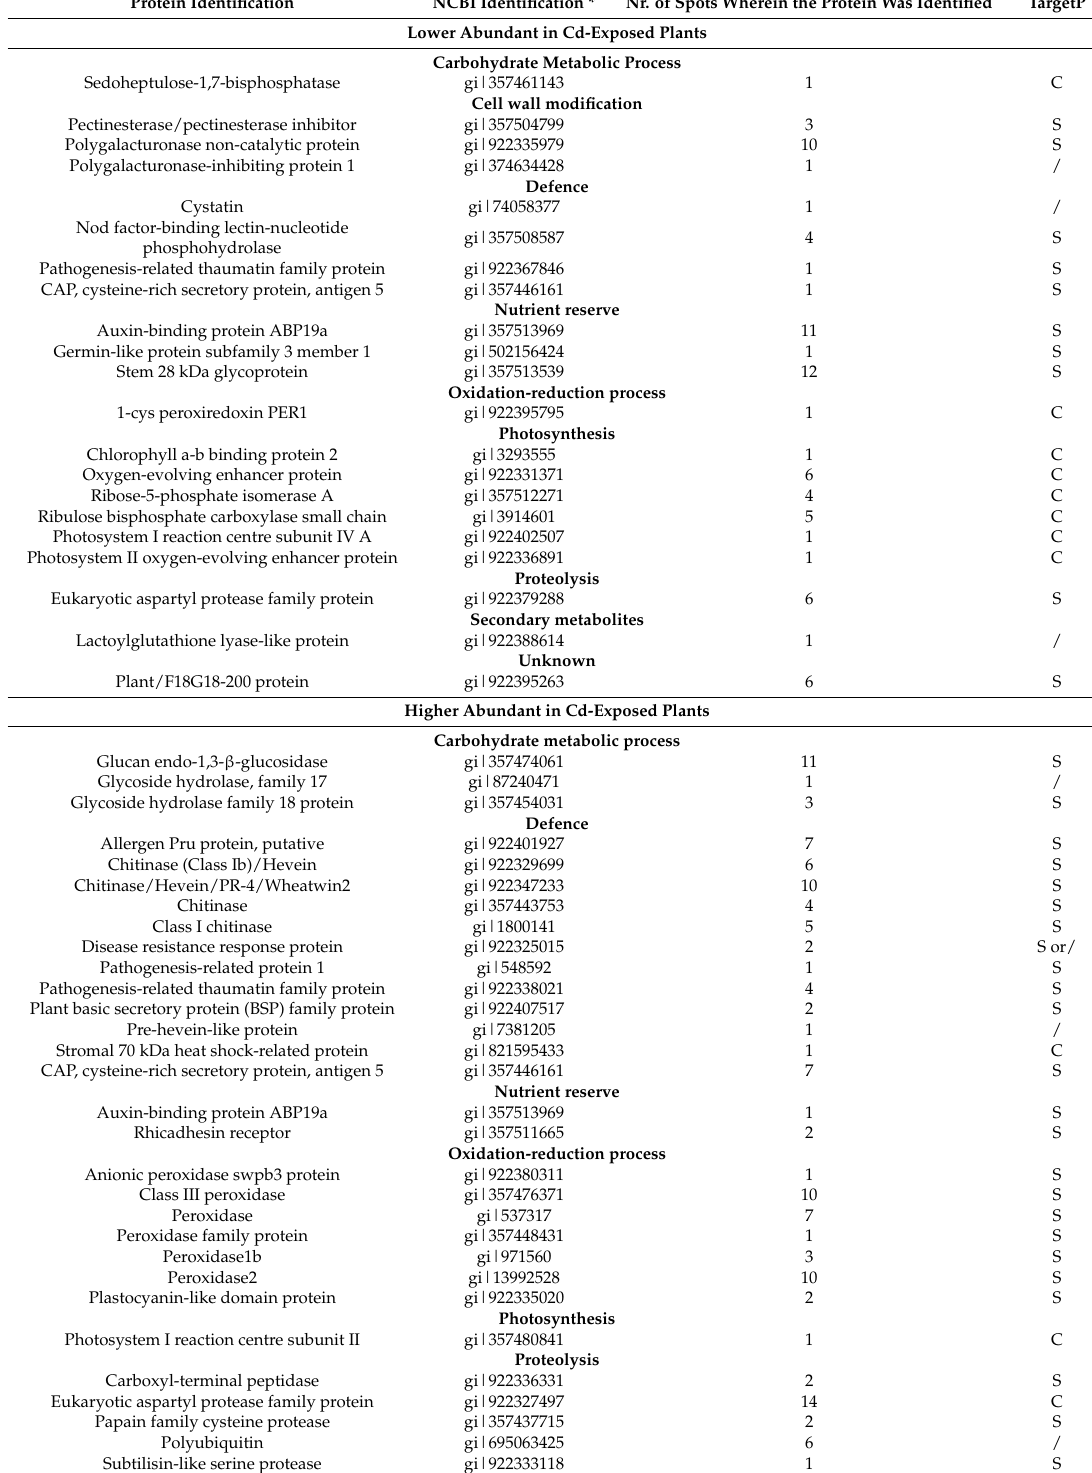
Table 1. Summary of all identified proteins in cell wall protein-enriched fractions from M. sativa leaves, which changed significantly in abundance after long-term Cd exposure. The table is based on all identifications provided in Table S2. The targeted location was predicted with TargetP. C: chloroplast; S: secretory pathway; /: any other